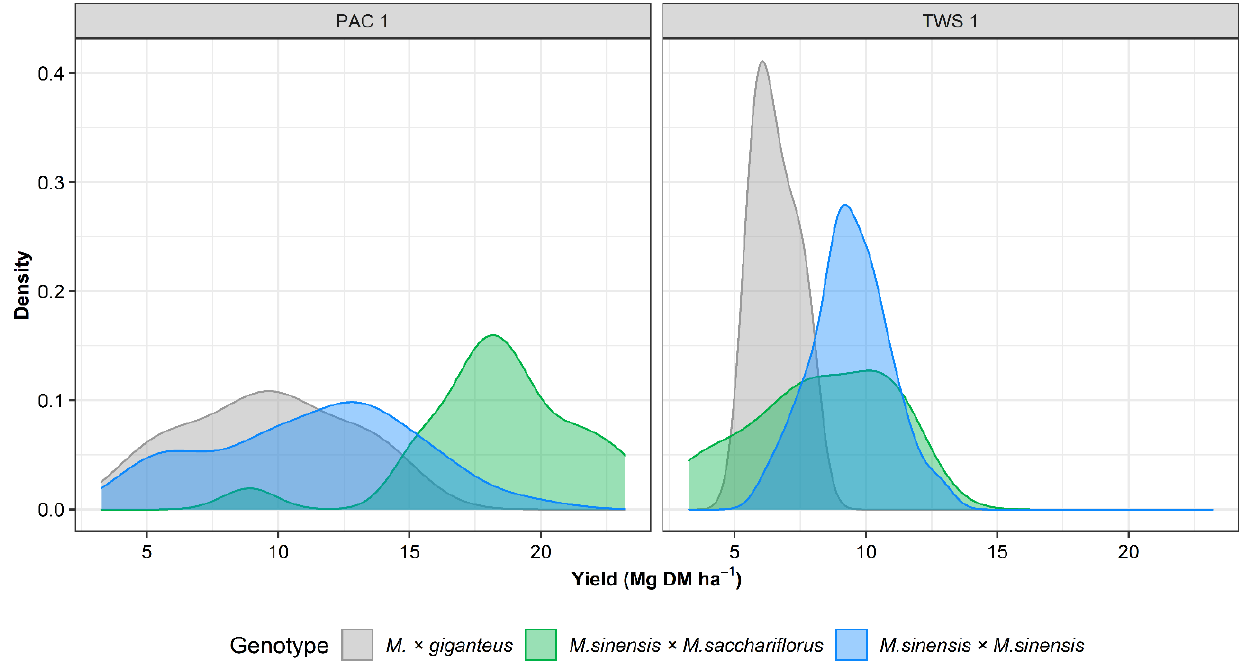
Figure 7. Frequency distribution of yield (Mg DM ha − 1 ) for the different Miscanthus hybrids at the two locations, PAC 1 and TWS 1.